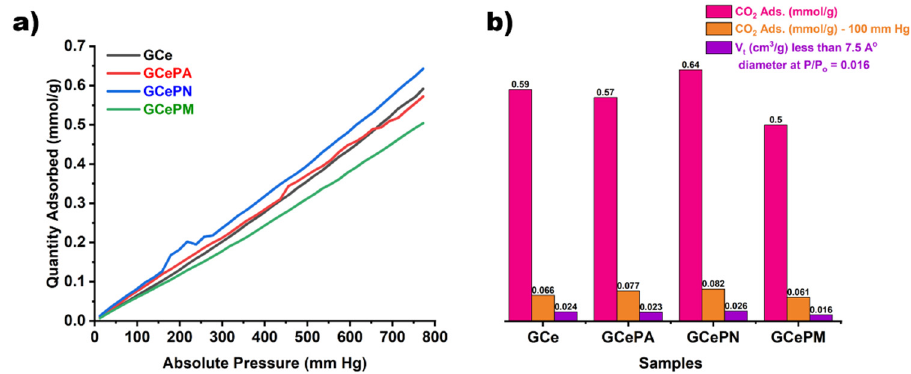
Figure 12. ( a ) Adsorption of CO 2 for all monoliths at room temperature and ( b ) comparison of CO 2 adsorption values for 760- (1 atm) and 100-mm Hg pressure, as long as the total pore volume is less than 7.5 Å in diameter at P/P o =